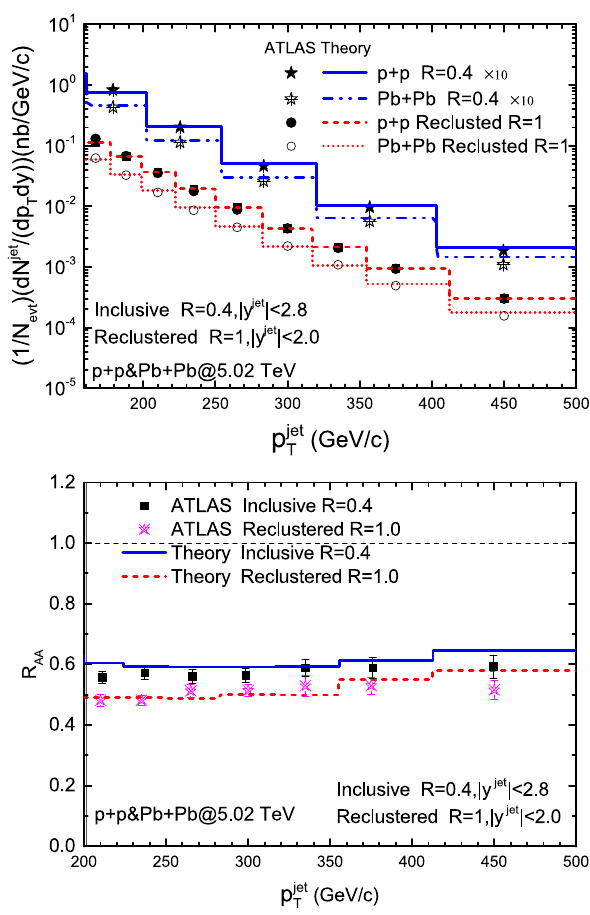
Fig. 1 Distributions of reclustered LR jets and inclusive jets in both p + p and Pb + Pb collisions with the comparison against the experi- mental data [83,101] (top). Nuclear modification factor R AA ( p jet reclusteredLRjetsandinclusivejetswithcomparisonagainsttheexper- imental data [83,101]